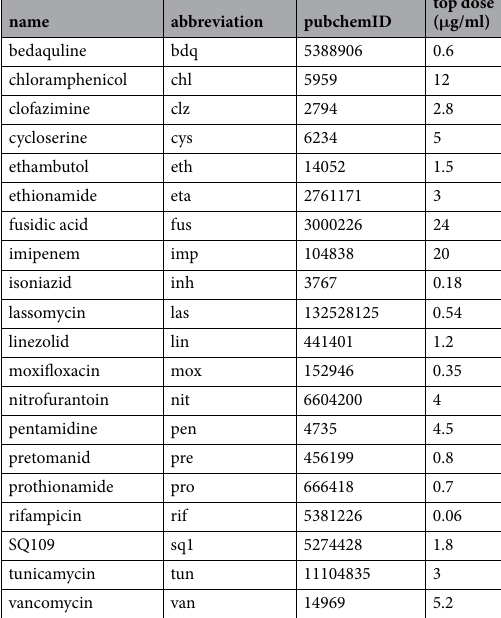
Table 1. Names, abbreviations, PubChemID and top doses for 20 compounds used in this